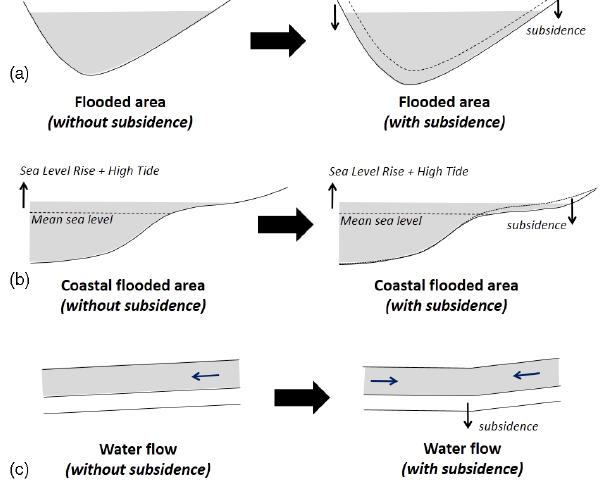
Figure 4. Impacts of land subsidence on flooding